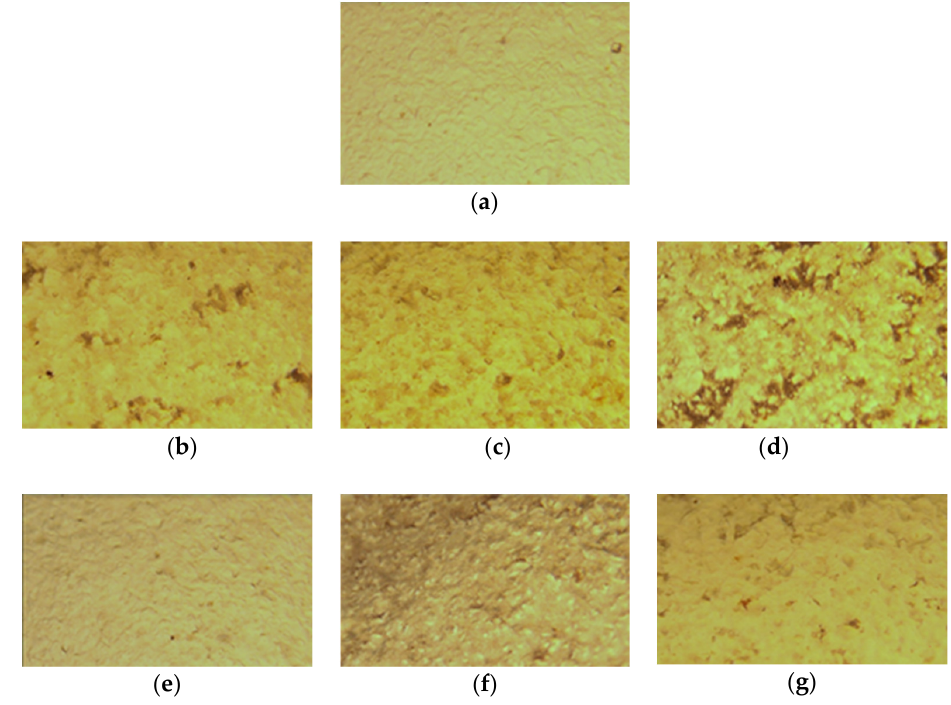
Figure 1. Optical microscopy images for ( a ) achira starch-PVA (SP) films with different concentrations of MMT (0.5, 1.0 and 1.5%), treated with (-s) and without sonication. 10 × magnification. ( a ) SP, ( b ) SP0.5MMT, ( c ) SP1.0MMT, ( d ) SP1.5MMT, ( e ) SP0.5MMT-s, ( f ) SP1.0MMT-s, and ( g )